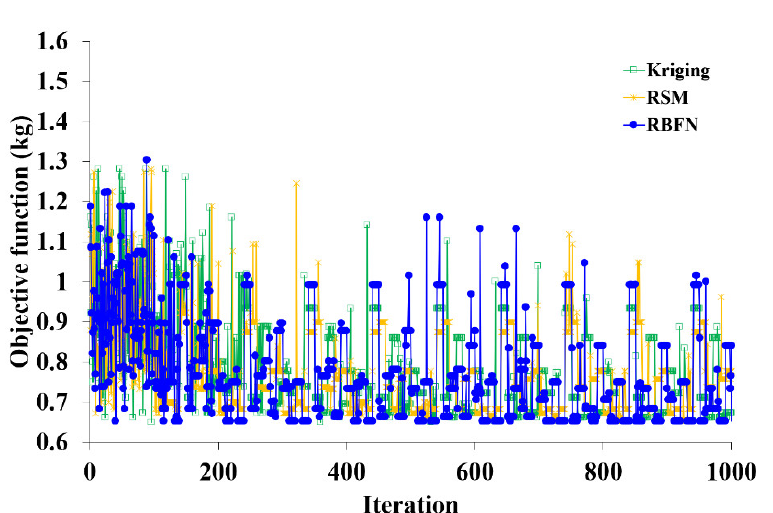
Figure 9. Iteration history of the objective function.